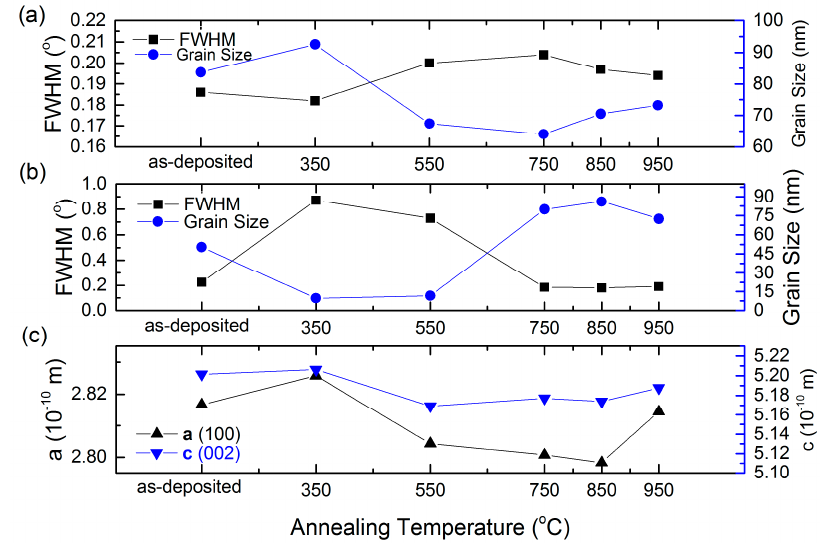
Figure 2. Variation of grain size, full-width at half-maximum (FWHM) and lattice constant with respect to annealing temperature: ( a ) FWHM and grain size with respect to annealing temperature for peak (100) in the XRD pattern; ( b ) FWHM and grain size with respect to annealing temperature for peak (002) in the XRD pattern; ( c ) lattice constant with respect to annealing temperature. Since transparent conducting oxide (TCO) coated glass is used as substrate in thin film solar cell fabrication, the smoothness of the surface affects the thin films’ deposition at the subsequent stage and thus device performance. Hence, it is important to study the surface morphology as a function of the annealing temperature of the ZnO:Zr films. Figure 3 shows the atomic force microscopy (AFM) images of the as-deposited and annealed ZnO:Zr films on a scanning area of 1 μ m × 1 μ m. No pin holes were observed in the micrographs, indicating successful deposition of compact films. As seen in Figure 4, the root mean square roughness (RMS) of the as-deposited films is about 2.5 nm, which is in good agreement with that reported by Yan et al. [30]. The grain size of the annealed ZnO:Zr films slightly decreases, as expected, before significantly increasing again at 850 °C. It can be observed in Figure 3 that the grain size parallel to the surface is getting smaller, while the grain size vertical with the substrate is larger. The former reflects the (100) crystalline orientation, and the latter corresponds to the (002) crystalline orientation. Hence, the transformation of the prominent crystalline orientation from (100) to (002) is attributed to RTA process, which is consistent with the hypothesis obtained from the XRD patterns.